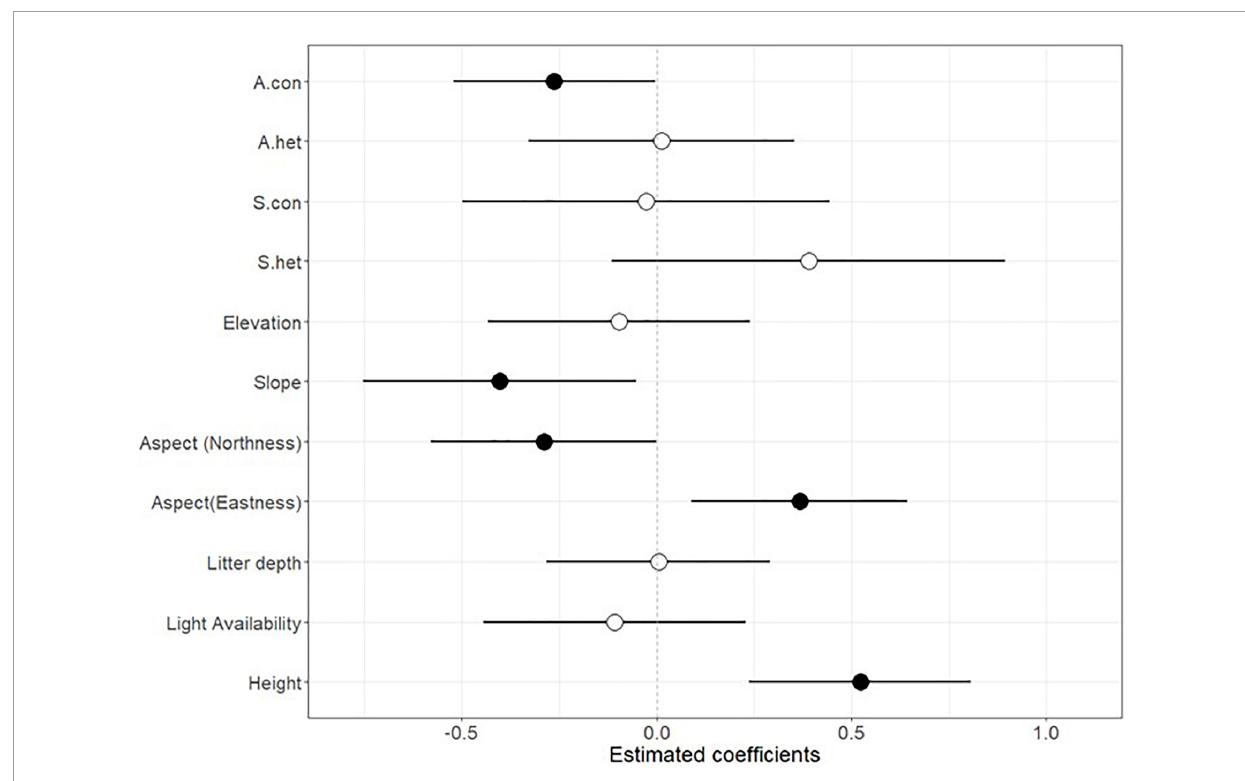
FIGURE2 Parameter estimates ( ± 2 SE) from generalised linear mixed effects model (GLMM) fitted to test the effects of abiotic and biotic factors on seedling survival of tree and shrub species in the Ngel Nyaki forest. Filled points indicate significant effects ( P <